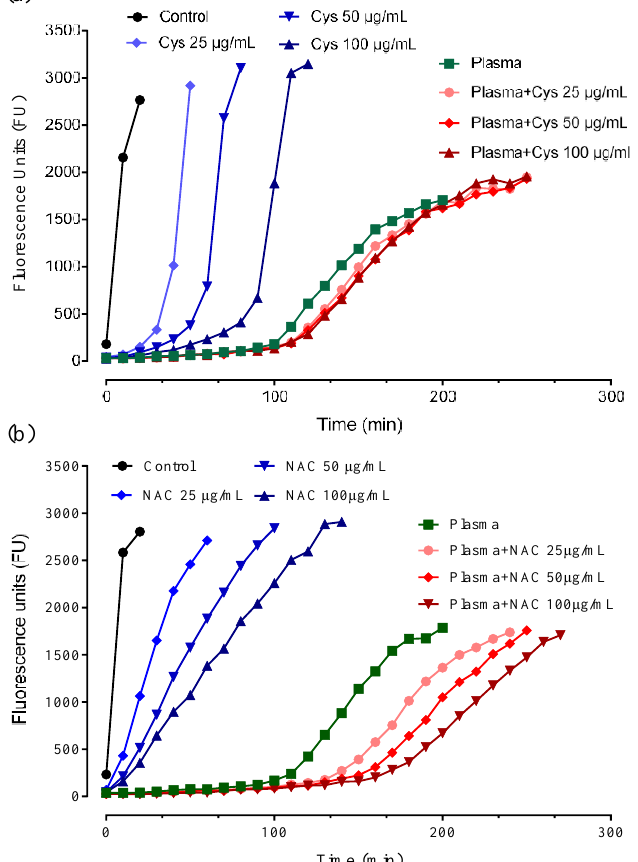
Figure 7. TRAP assay: Antioxidant activity of Cys ( a ) and NAC ( b ) in absence (filled symbols) and presence (empty symbols) of human plasma.